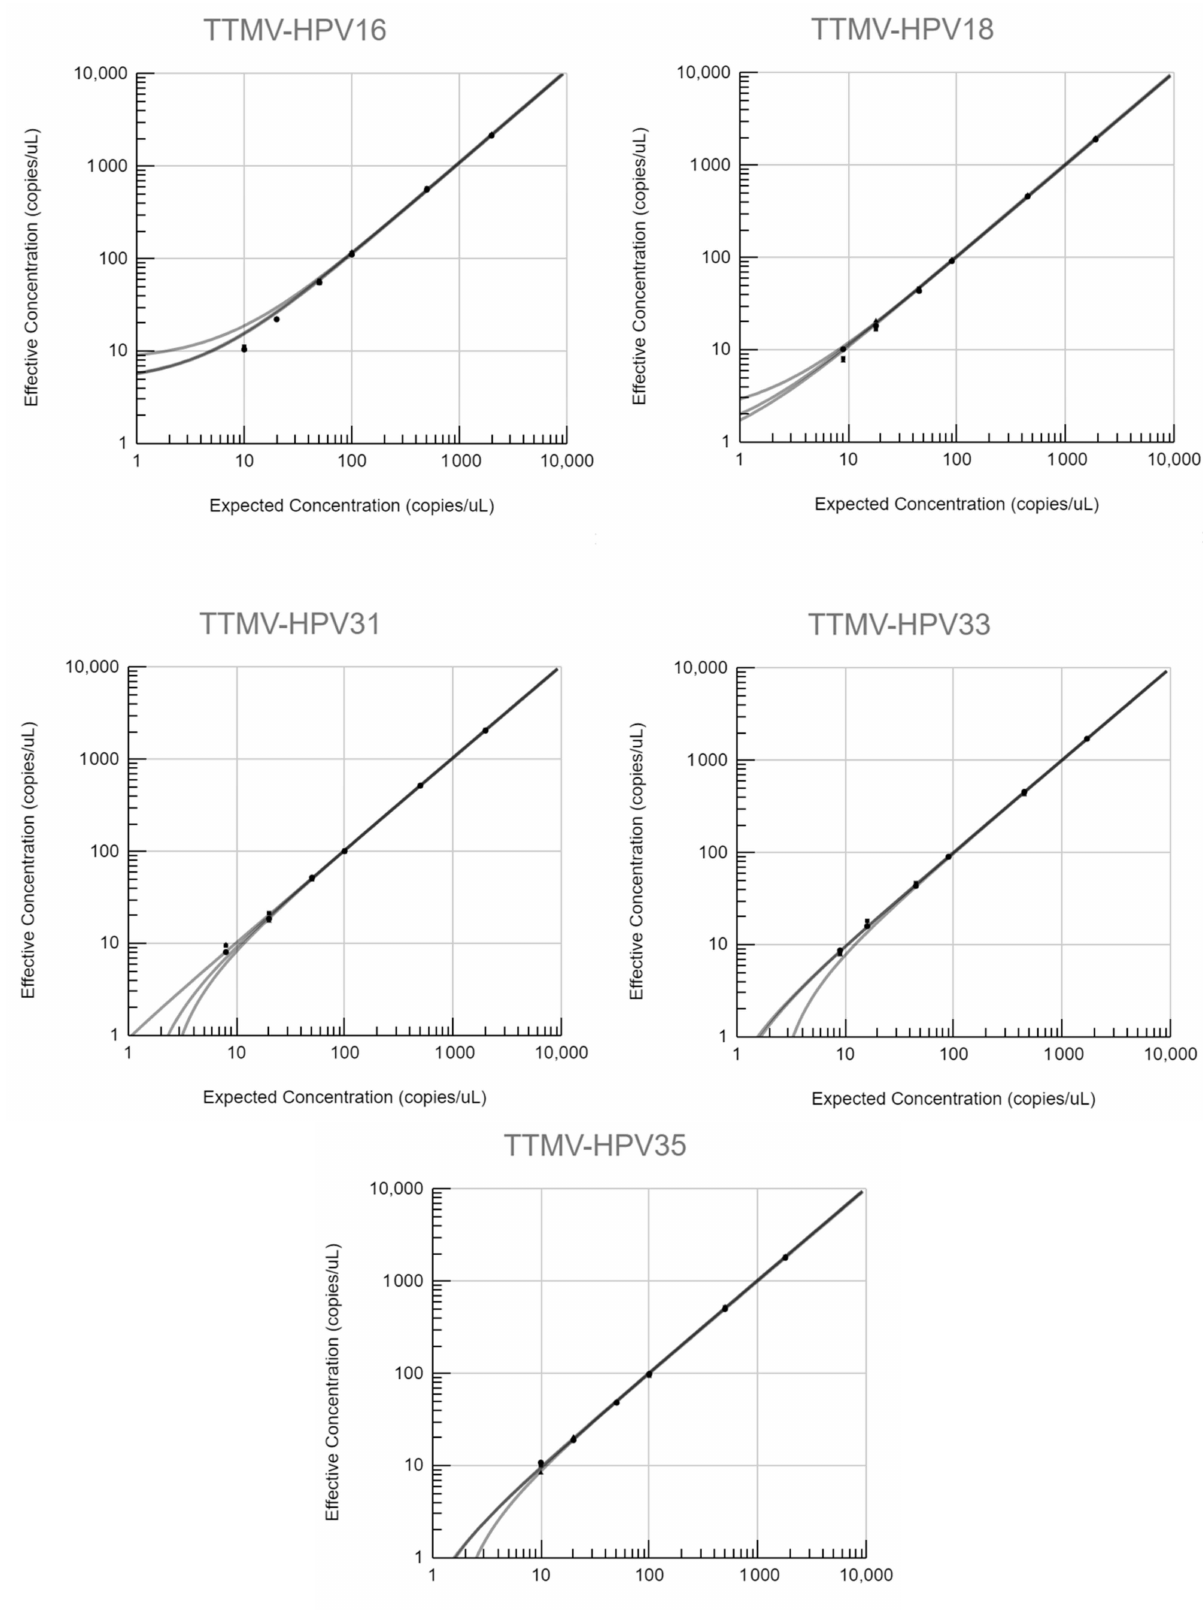
Figure 1. Linearity plots for TTMV-HPV16, 18, 31, 33 and 35 DNA at six different concentrations on days one, three and five. Corresponding equations and R 2 values are given in Table 5